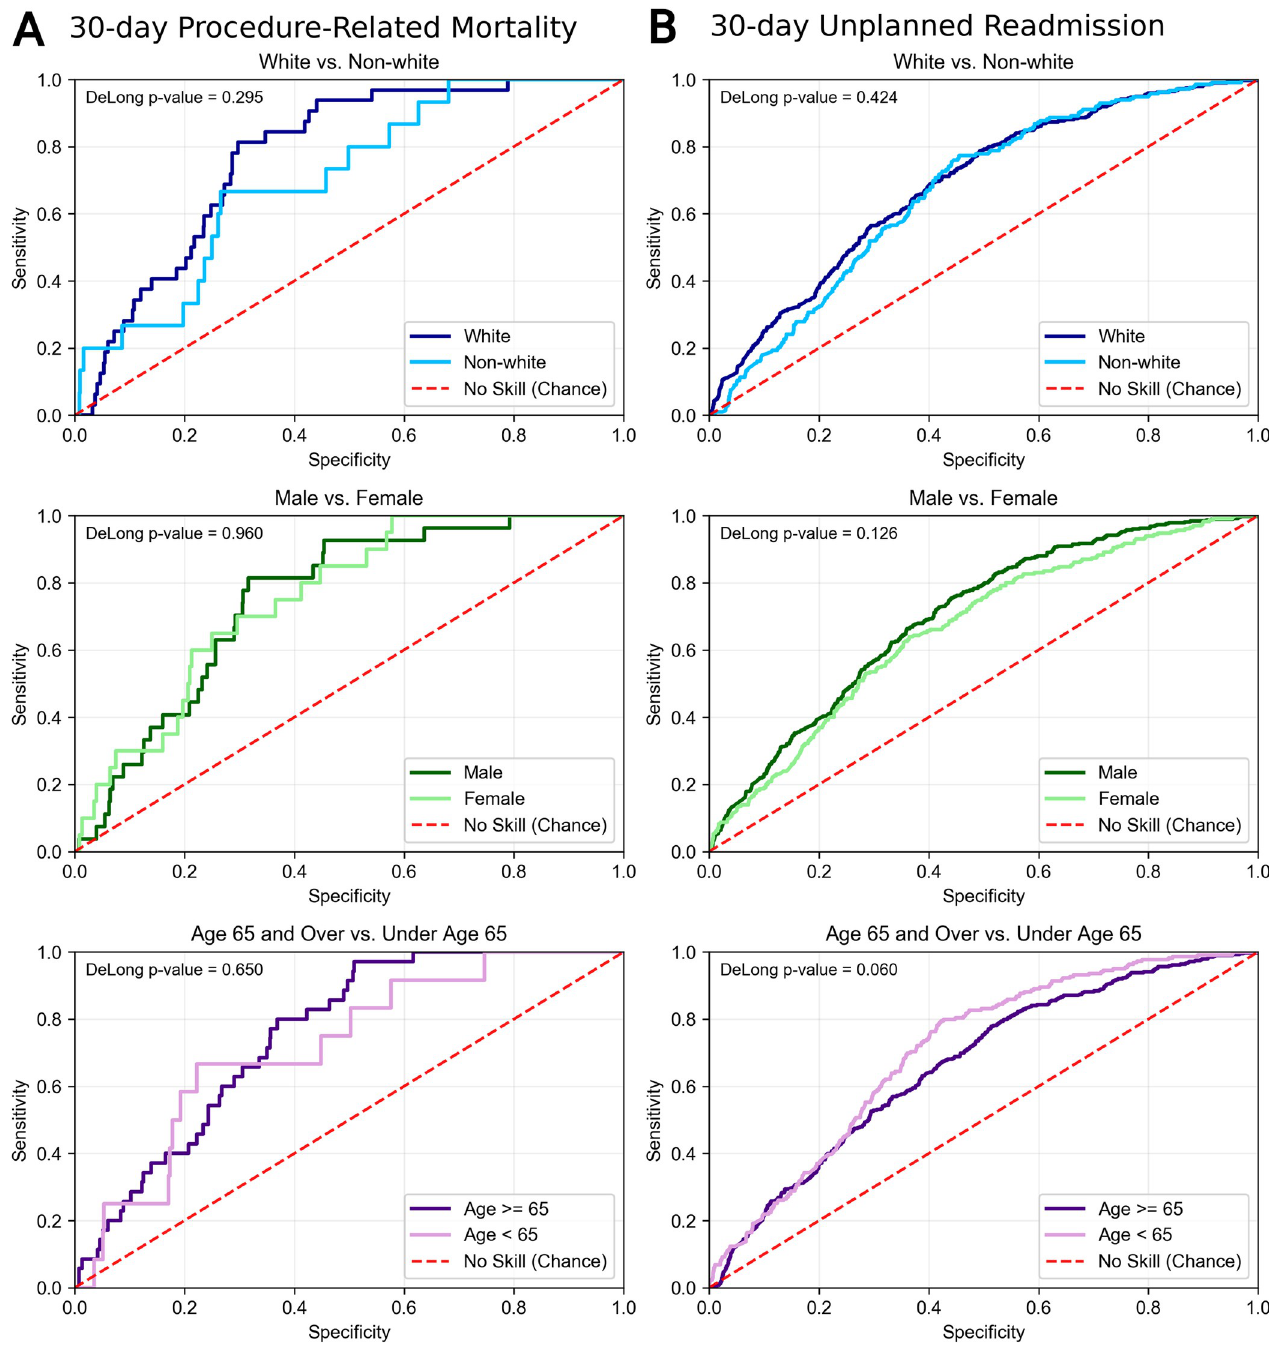
Fig 5. Model performance on demographic subgroups of the test set, demonstrating equivalent performance on race (white and non-white), sex (male and female), and age (under age 65 and 65 and older) groups.